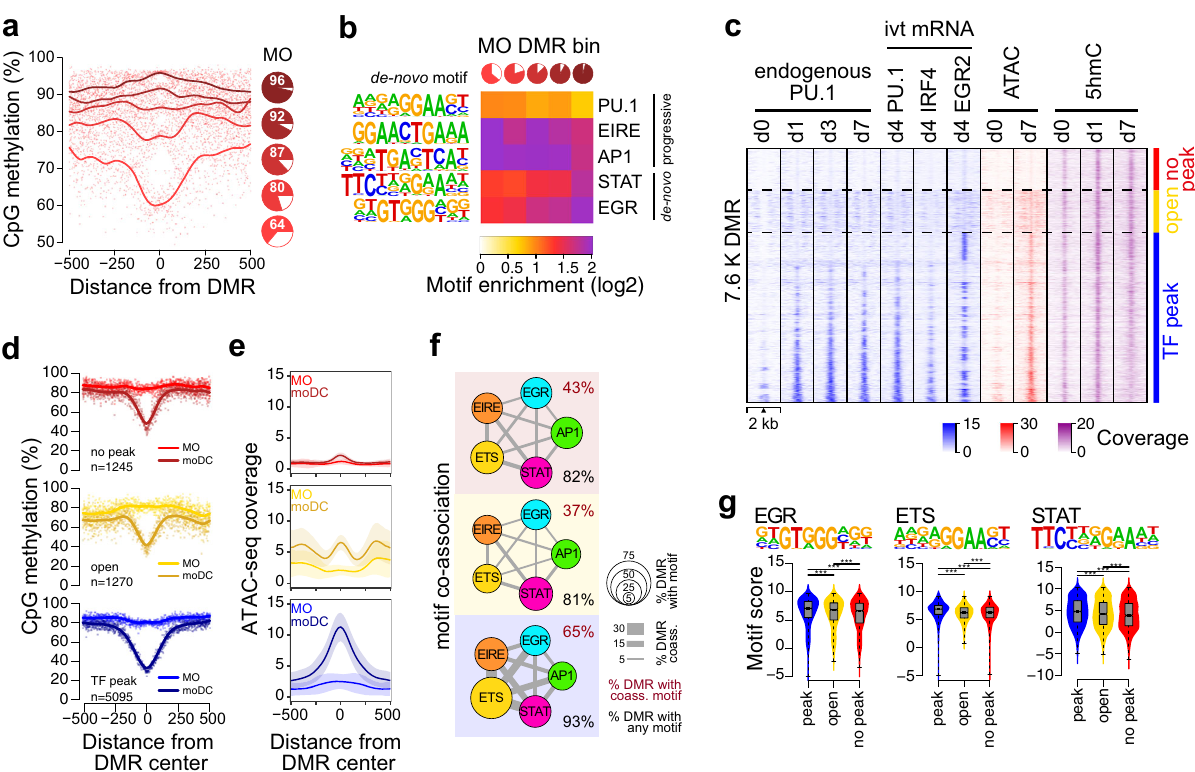
Fig. 3 TF signatures at DMR. a Genomic distance distribution of mean methylation ratios in MO centered on DMR demethylated in moDC. Pie charts represent the mean methylation level (in red) of DMR quantiles (1.5K each) sorted by their mean methylation ratio in MO. b Heatmap of motif enrichment (compared to background) for the indicated TF contingent on DMR quintiles based on the methylation state of MO (pie charts shown on the top and in ( a )). c Distribution of ChIP-seq (native PU.1 and FLAG-tagged versions of PU.1, IRF4, and EGR2 derived from transfected, in vitro-transcribed (ivt) mRNA), ATAC-seq, and 5hmC signals across the 7610 DMR demethylated in moDC at the indicated time points of moDC differentiation. DMR are divided into three majors groups characterized by detectable TF binding (blue, “ TF peak ” ), the presence of open chromatin without detectable TF binding (yellow, “ open ” ), and the absence of open chromatin and lack of detectable TF binding (red, “ no peak ” ). d Genomic distance distribution of averaged DNA methylation ratios in MO and moDC centered on DMR demethylated in moDC in “ TF peak ” ( n = 5058), “ open ” ( n = 1270), and “ no peak ” ( n = 1245) groups. e Genomic distance distribution of ATAC-seq coverage in MO and moDC centered on DMR demethylated in moDC in “ TF peak ” , “ open ” , and “ no peak ” groups. Shaded bands represent the 95% con fi dence intervals. f Motif co-association networks for “ TF peak ” , “ open ” , and “ no peak ” groups. The size of each node represents the motif enrichment (fraction of peaks) and co-associated TF motifs are indicated by coloring. Edge thickness indicates the frequency of motif co-association. The fraction of DMR with co-associated motifs and the fraction of DMR with any motif are given above and below each network, respectively. g Combined bean and box plot showing EGR, ETS, and STAT motif log-odds score distributions for “ TF peak ” , “ open ” , and “ no peak ” groups. Solid bars of boxes display the interquartile ranges (25 – 75%) with an intersection as the median; whiskers represent max/min values. Signi fi cantly different motif score distributions in pairwise comparisons are indicated (*** P < 0.001, Mann – Whitney U test, two-sided). ( a , b , d – g ) Source data are provided as a Source Data